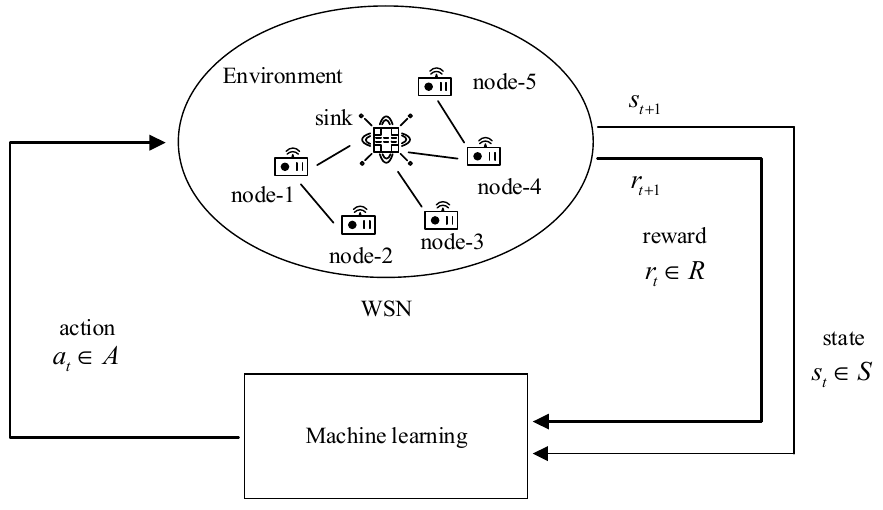
Figure 7. The proposed ML-based system model.